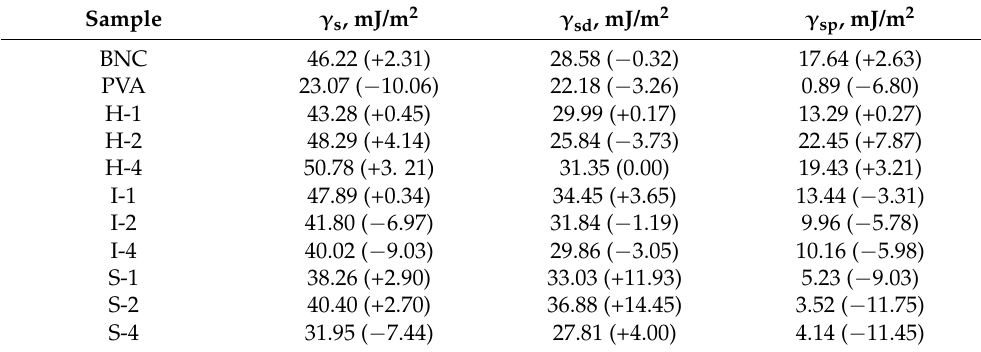
Table 3. Total surface free energy ( γ s ) and its dispersion ( γ sd ) and polar ( γ sp ) components of 4 h UV-irradiated BNC and BNC/PVA blends obtained by various methods. The differences between the values with the non-irradiated samples are given in parentheses 1